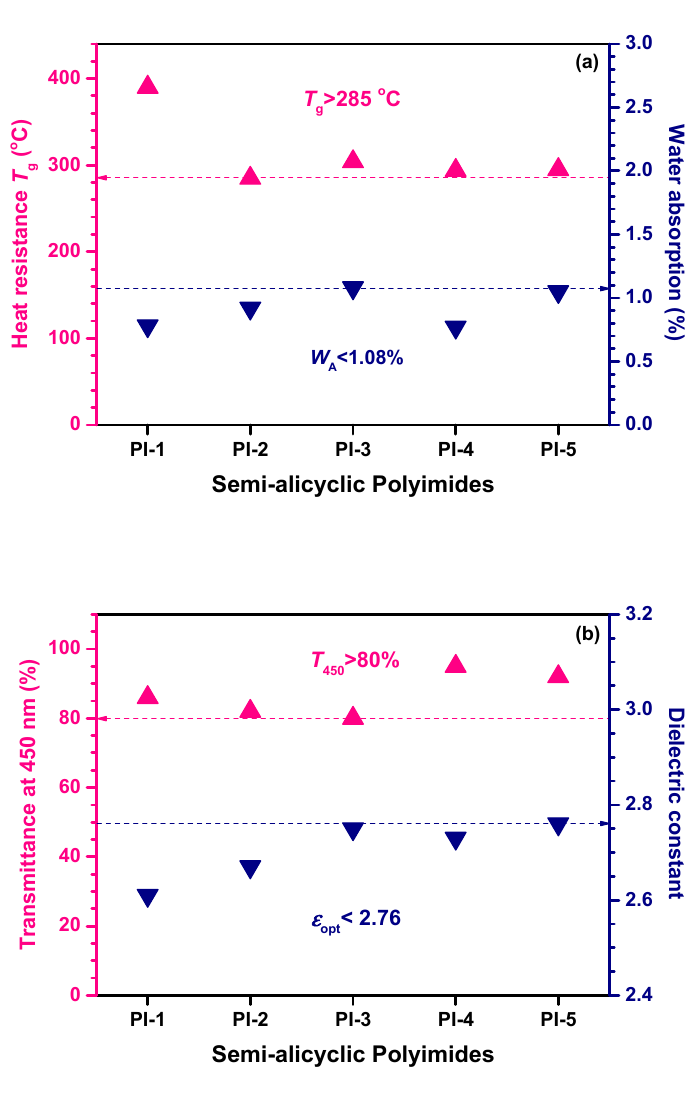
Figure 6. The performance of semi-alicyclic polyimides prepared in the present work.